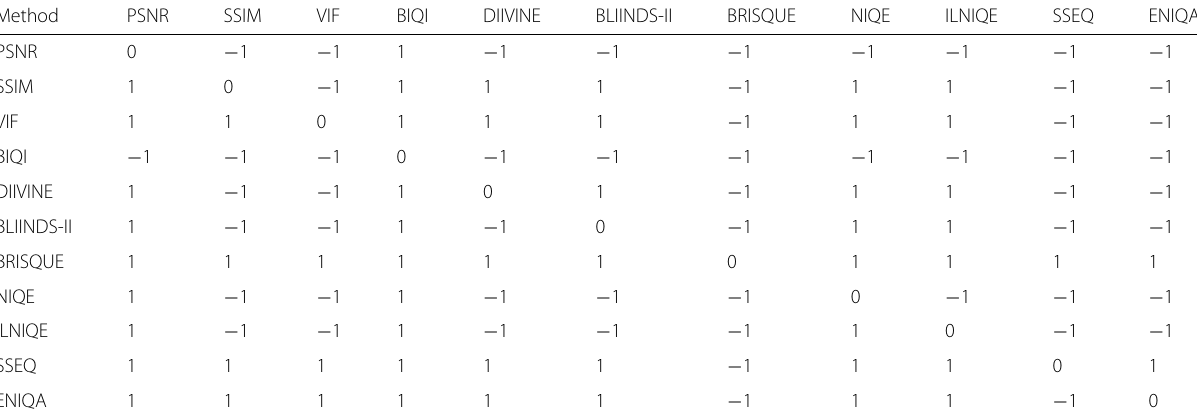
Table 5 Results of the t -tests performed between SROCC values